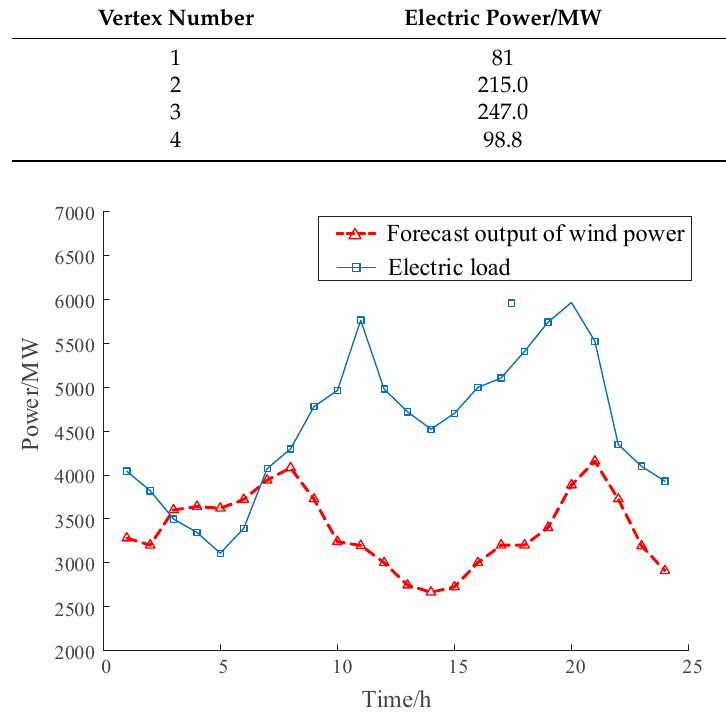
Figure 5. Output power forecasting of wind power and load.